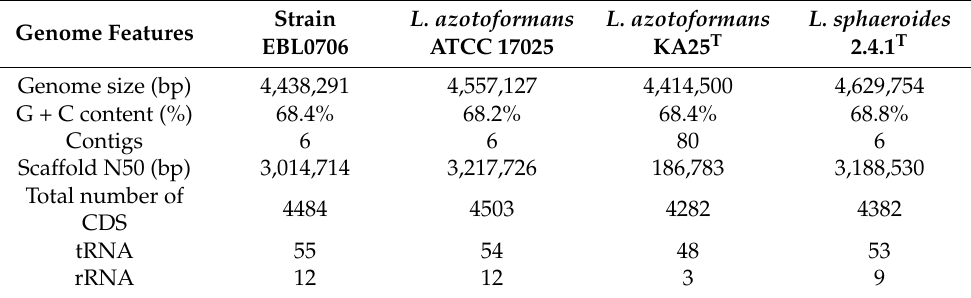
Table 1. Genome features of strain EBL0706, L. azotoformans ATCC 17025, L. azotoformans KA25 T , and L. sphaeroides 2.4.1 T